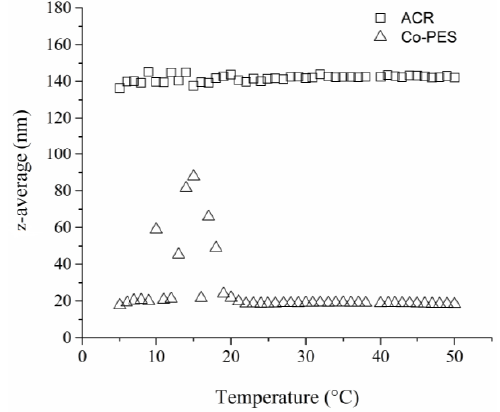
Figure 4. z-average temperature dependence of ACR dispersion ( squares ) and Co-PES dispersion ( triangles ).